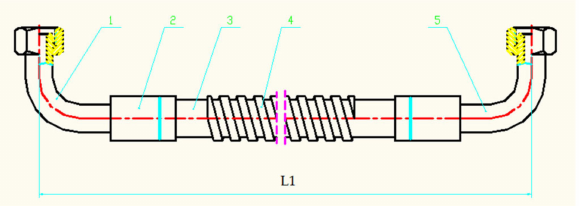
Figure 2. Hydraulic hose assembly. 1—connector 1; 2—sleeve; 3—hose; 4—spring sheath; 5—connector 2.